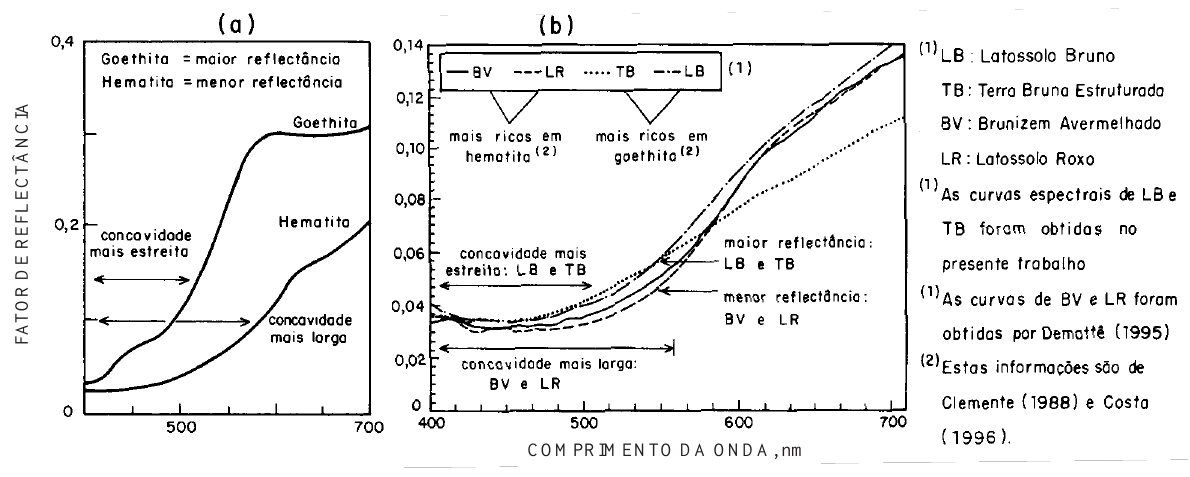
Observação: As curvas da hematita e da goethita foram extraídas de Vitorello & Galvão (1996), com exceção das Figura 5. Avaliação das curvas da hematita e da goethita e sua relação com as curvas espectrais dos solos.